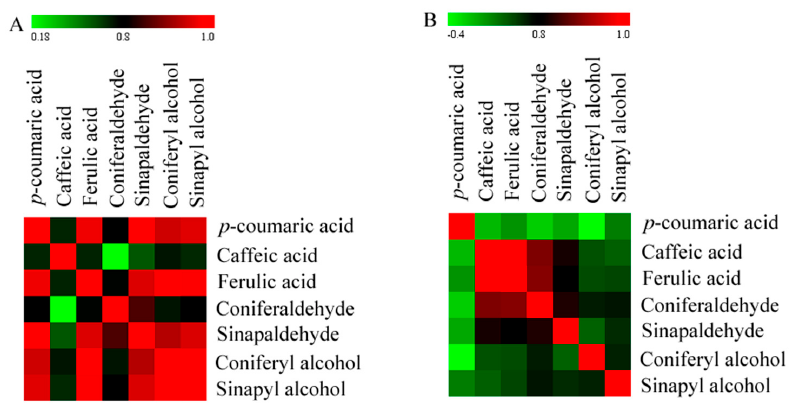
Figure 8. Heat map representing the correlations of lignin intermediate metabolites in pear fruit. ( A ): 47 DAPs; ( B ): 63 DAPs.